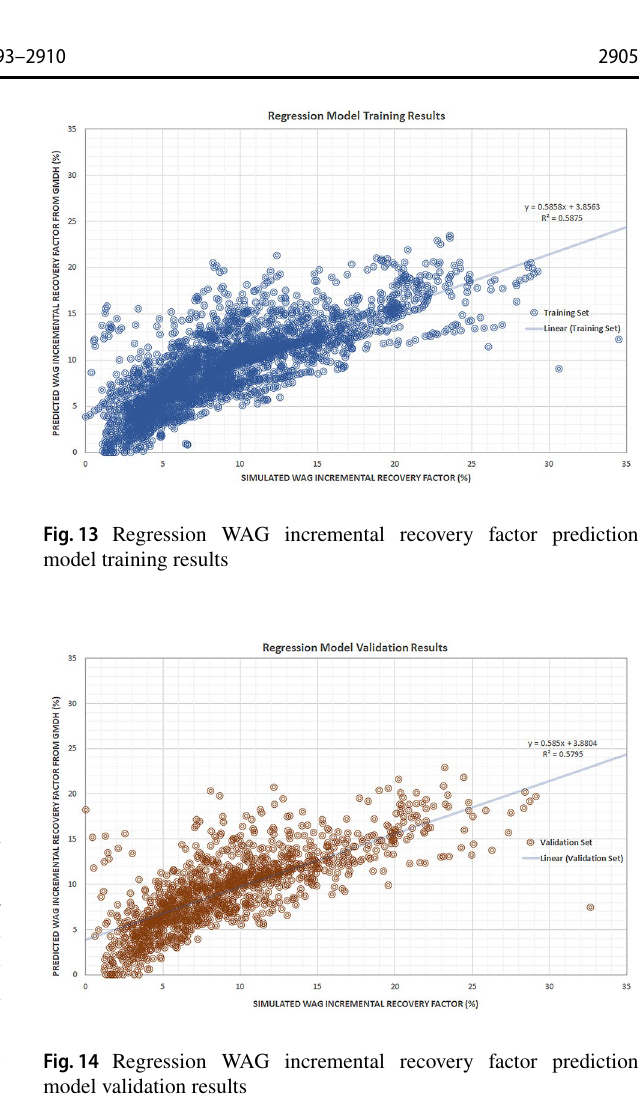
Fig. 14 Regression WAG incremental recovery factor prediction model validation results